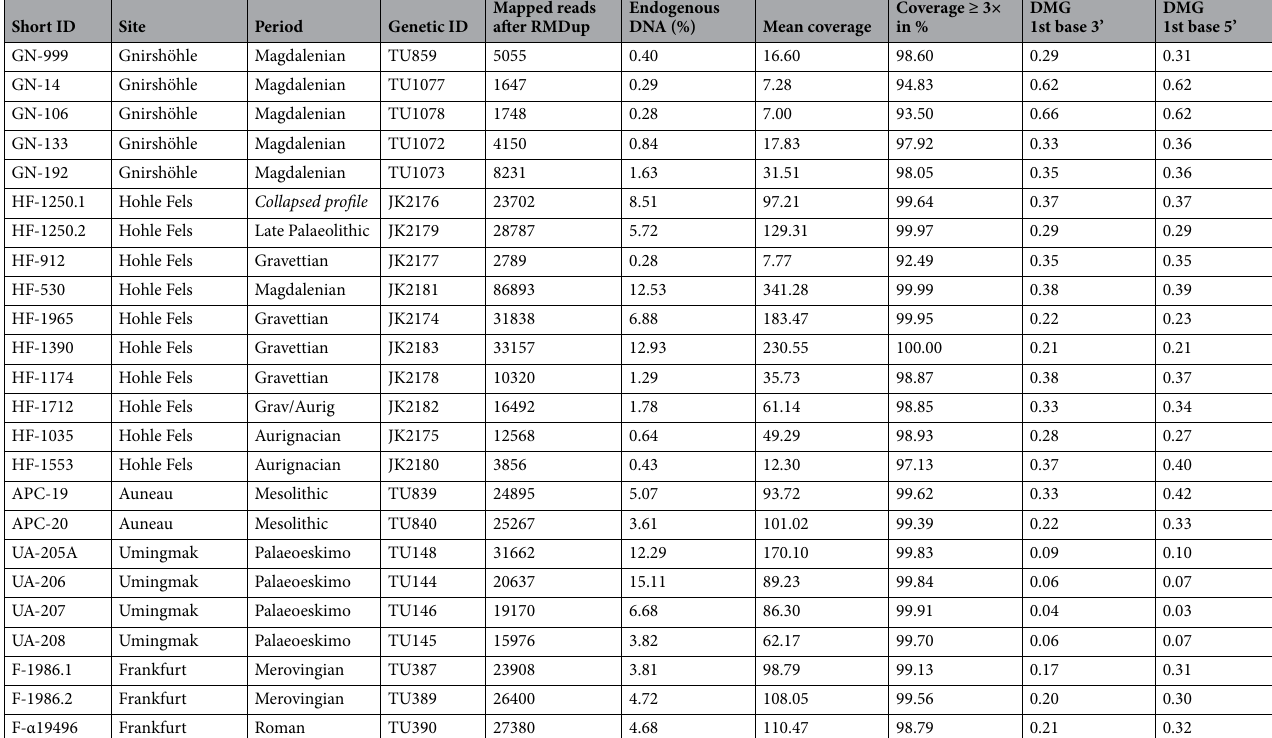
Table 2. Results of the genetic analysis. Table represents the number of mapped reads against the reference genome (after duplicate reads removal), endogenous DNA content, the percentage of mitochondrial genome bases covered at least 3-fold and the fraction of 1st base damage at the 3’ and 5’ end of the mapped sequences reads. HF-1250.1 and HF-1250.2 were concluded as one individual according to genetic and archaeological analysis and were merged into one sample for downstream